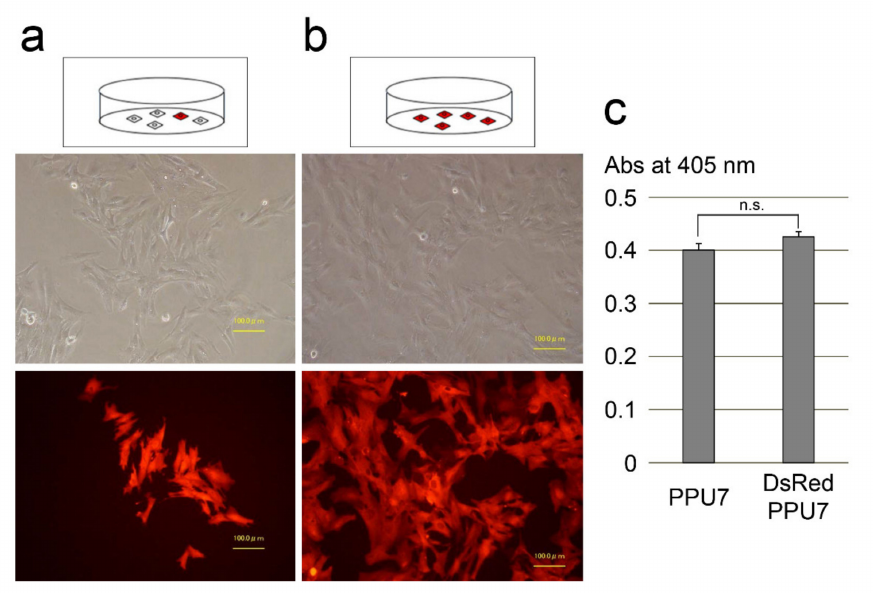
Figure 1. Gene transfection of Discosoma species’ red fluorescent protein (DsRed) into a porcine dental pulp cell line (PPU7). ( a ) DsRed-PPU7 cells immediately after liposome transfection (scale bar: 100 µ m). ( b ) DsRed-PPU7 cells obtained by cloning with limited dilution (scale bar: 100 µ m). ( c ) Inherent alkaline phosphatase (ALP) activity in cells before (PPU7) and after (DsRed-PPU7) gene transfection ( n = 6). n.s., not significant di ff erence.